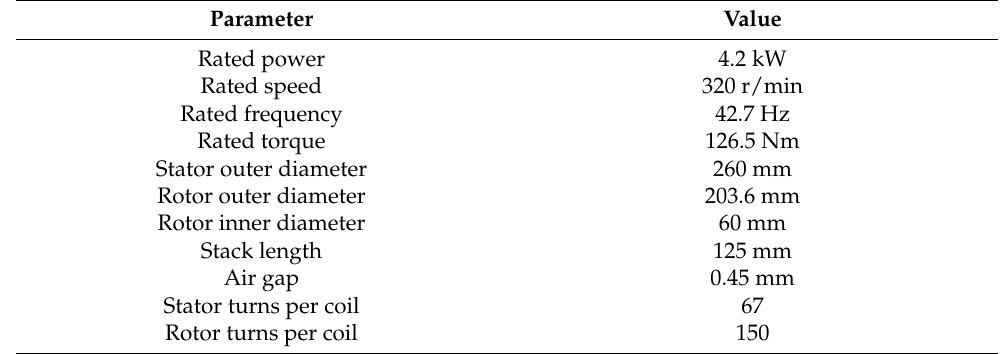
Figure 3. Two-dimensional model of the double-layer 16/18 pole/slot WRSG and coil arrangement, with light (positive) and dark (negative) colors. Table 1. Specifications of the 16/18